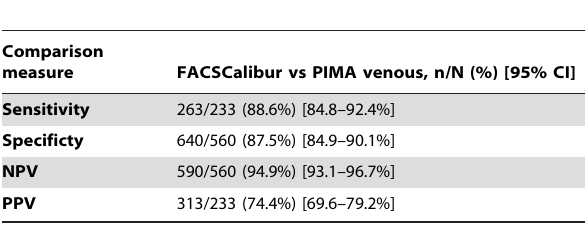
Table 3. Sensitivity, Specificity, NPV and PPV at 350 cells/uL ART eligibility threshold.